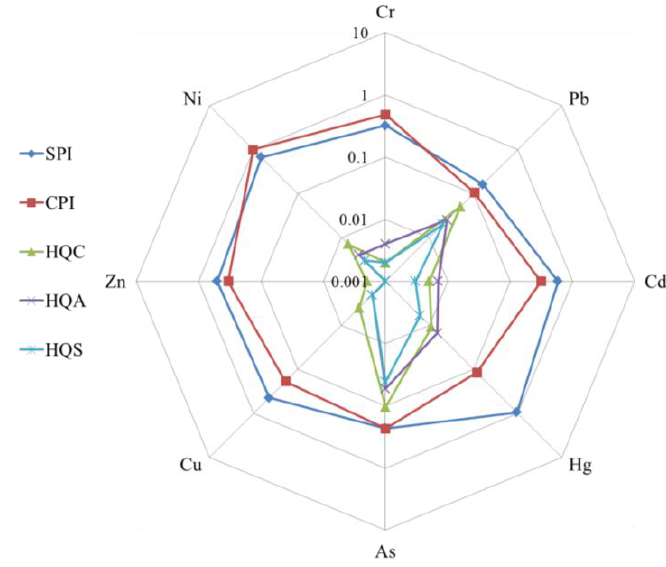
Figure 8. The radar sequence diagram of the mean SPI, CPI, and HQ for different heavy metals. The standard exceeding rates of SPI, CPI, and HQ—and all HQs for children, adults, and seniors—for eight HMs were 0, showing that the non-carcinogenic risks in all samples were at the safety level. Great differences existed in the standard exceeding rates of HMs between soil and plants. As shown in Figure 9, the standard exceeding rates of Cu, Hg, and Cd in soil were significantly higher than the corresponding values in crops. Meanwhile, the standard exceeding rates of Ni, As, and Cr in crops were significantly higher than the corresponding values in soil.